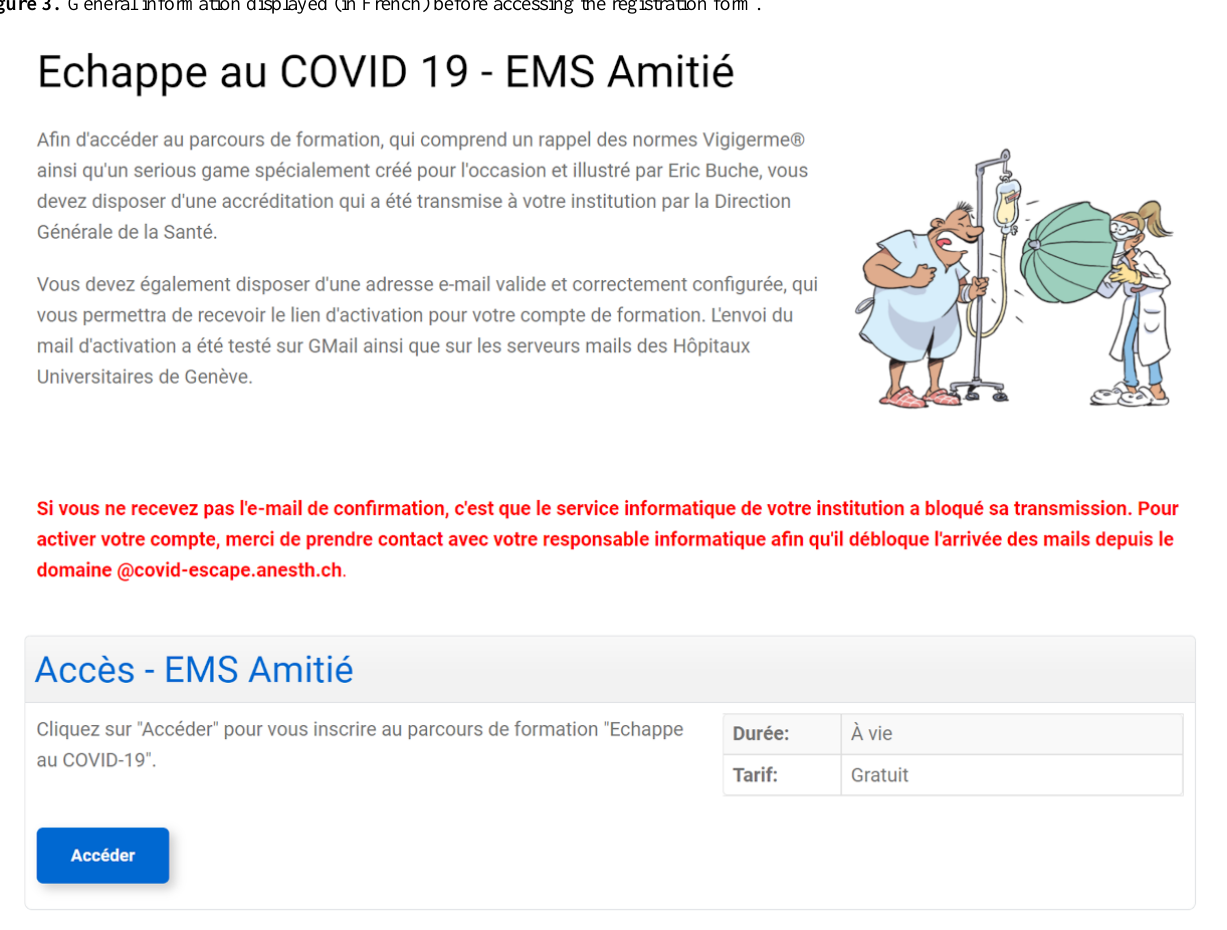
Figure 3. General information displayed (in French) before accessing the registration